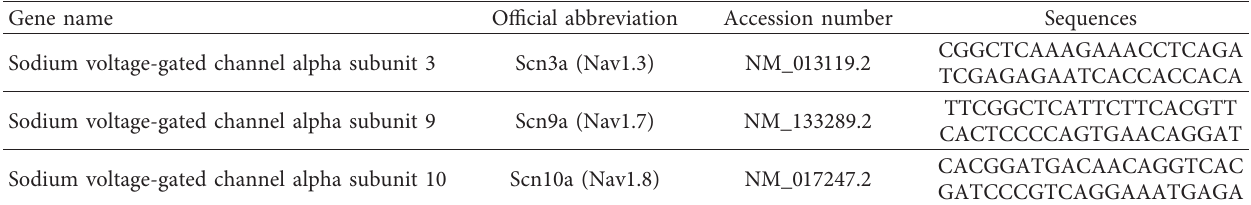
Table 1: Primer sequences of sodium channel alpha subunit genes according to NCBI gene